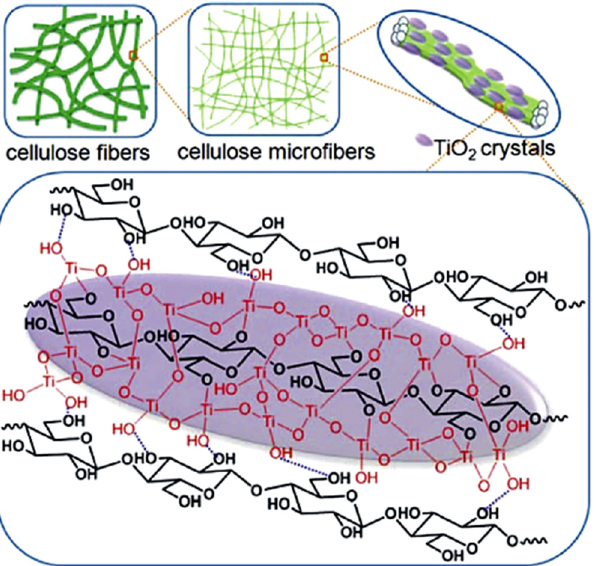
Figure 4. The schematic illustration of the in situ directional growth of spindle TiO 2 along the cellulose microfibers. Reprinted from [ 156 ] . Copyright 2015, with permission from Elsevier Ltd.